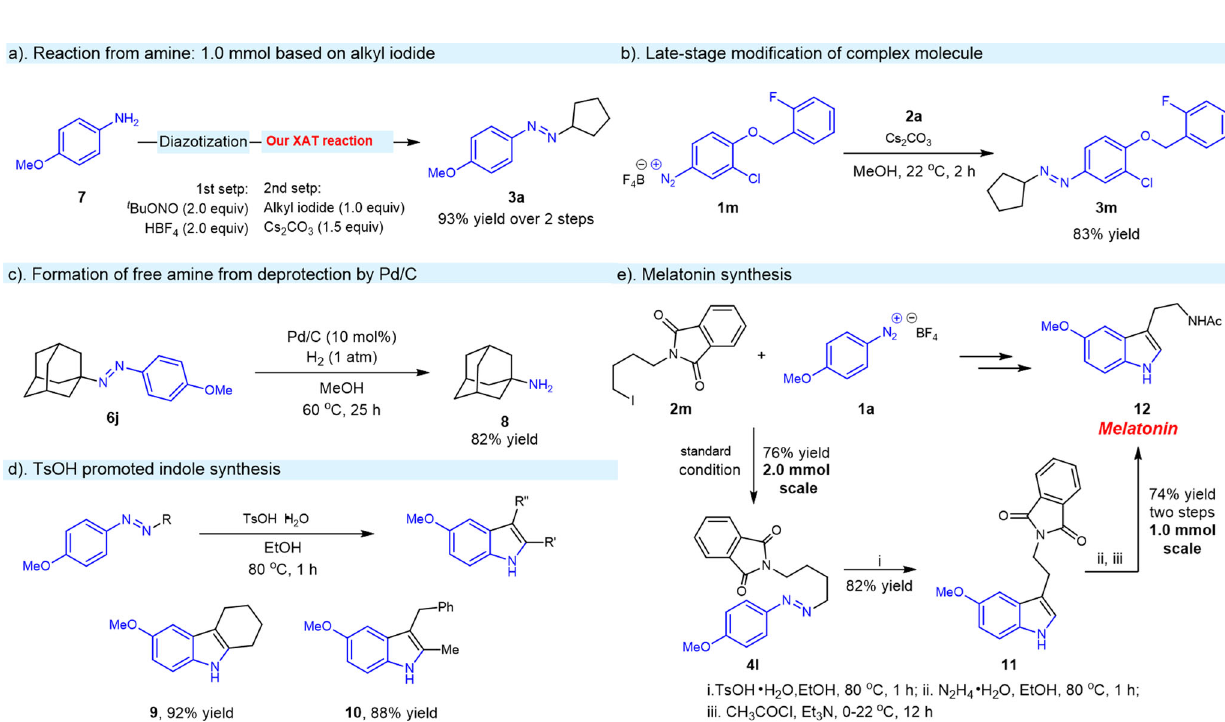
Fig. 6 | Synthetic applications. a Reaction from amine: 1.0mmol based on alkyl iodide. b Late-stage modi fi cation of complex molecule. c Formation of free amine from deprotection by Pd/C. d p -Toluenesulfonic acid monohydrate promoted indole synthesis. e Melatonin synthesis.